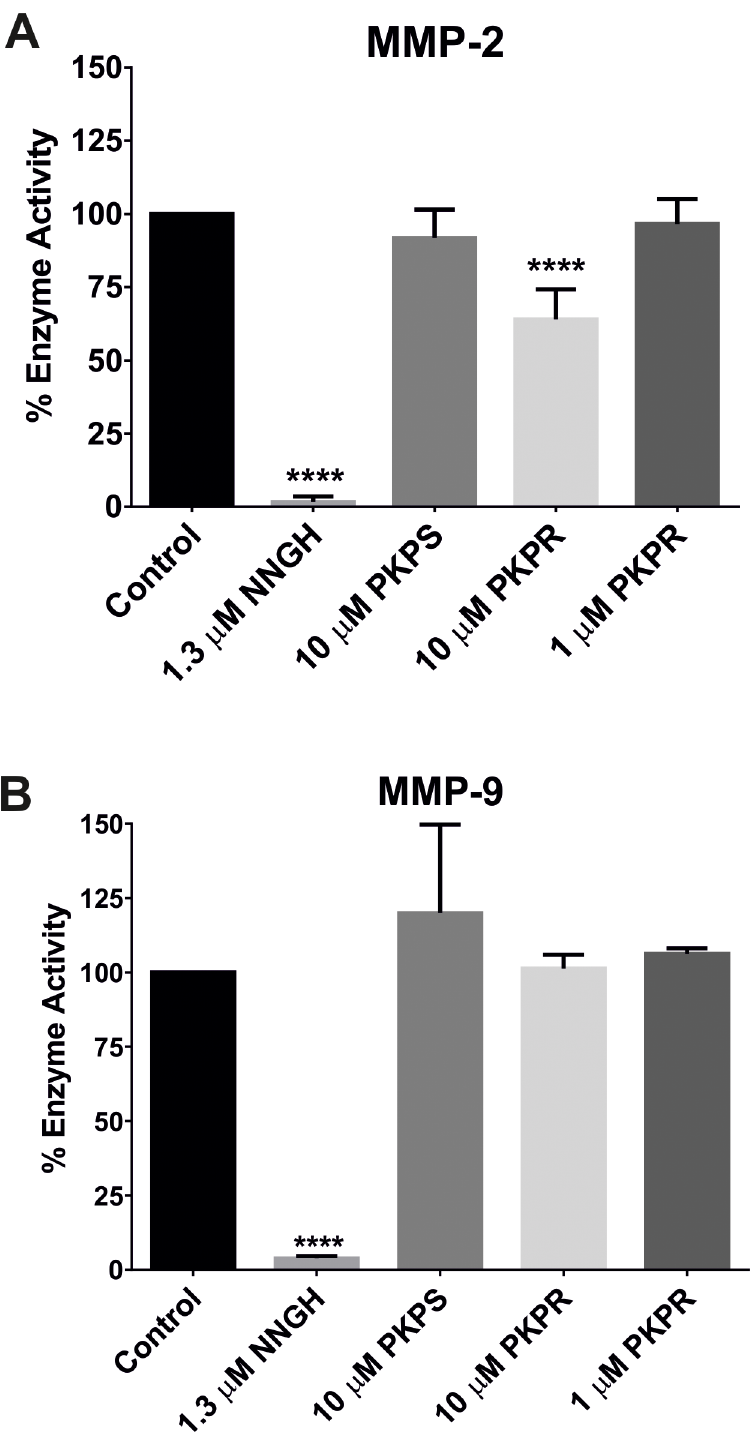
Fig 7. Effect of KP phosphinic peptides on MMP-2 (A) or MMP-9 (B) enzyme activity. The inhibition assays on MMPs were conducted using MMP colorimetric drug discovery kits in 96-well microtiter plates as per